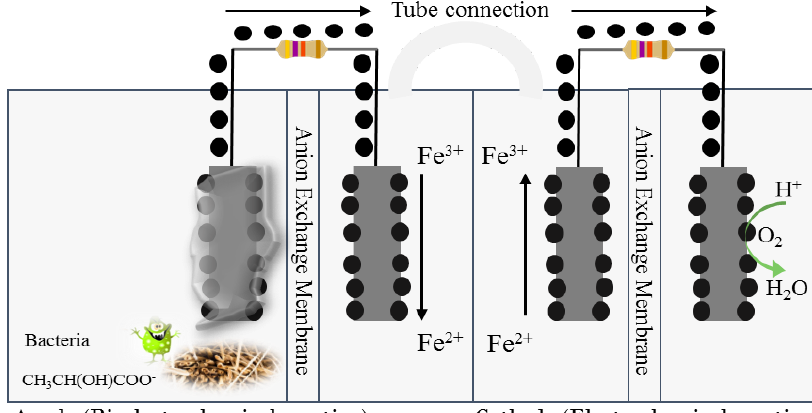
Figure 3. Schematic design of microbial fuel cell configuration.